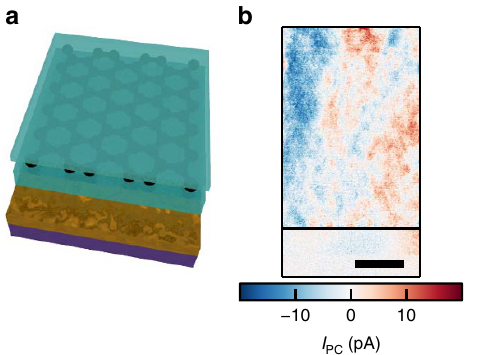
Figure 6 | Edge doping is efficiently suppressed using devices with local metal gates. ( a ) Sketch of the device with local metal gate with the two h-BN layers in light blue and the local metal gate in gold. The layers are from bottom to top SiO 2 (300nm)/AuPd(15nm)/h-BN(42nm)/Graphene/ h-BN(13nm). ( b ) Photocurrent from charge puddles in encapsulated graphene on a metal gate close to the charge neutrality point. The electrical contacts are on the left and right outside of this figure. (scale bar, 2 m